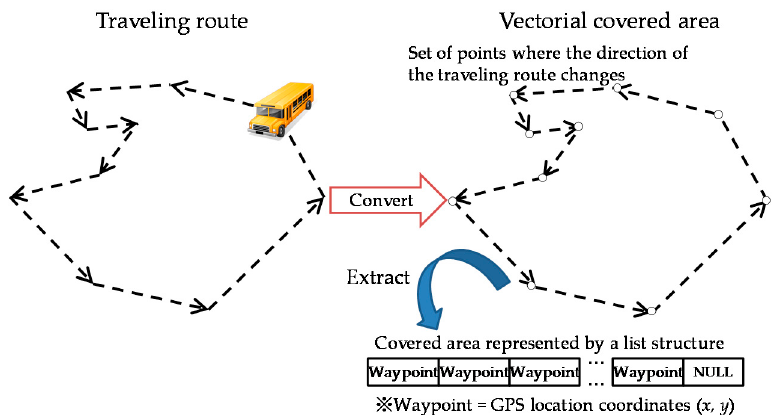
Figure 5. Example of generating a vectorial covered area.